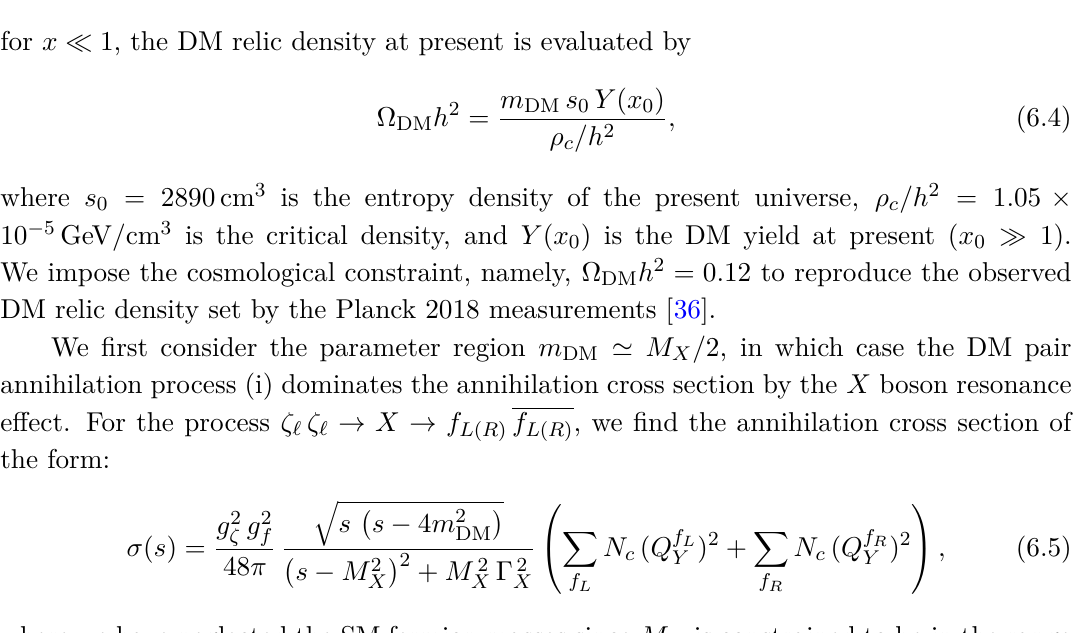
Figure 4 . Left panel : the resultant DM relic densities for a = 0 . 5 (blue), a = 1 (green) and a = 2 (red), respectively, as a function fo m DM , along with the observed value (dashed horizontal line) of Ω DM h 2 = 0 . 12 . In this analysis, we have fixed g BL = 0 . 6 and M X = 4 TeV. Right panel : the resultant DM relic densities for a = 1 and M X = 4 TeV, along with the observed value (dashed horizontal line) of Ω DM h 2 = 0 . 12 . The blue, green and red lines from top to bottom, respectively, correspond to the results with g BL = g BL | = 0 . 727 , 0 . 6 and g BL | = 0 . 431 (see table max min